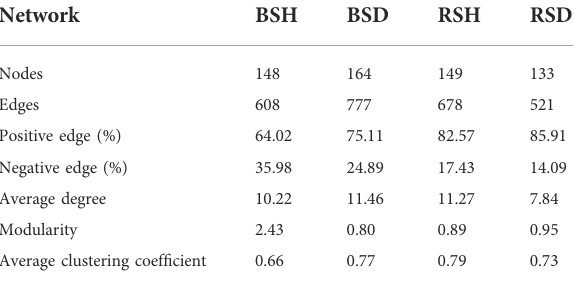
TABLE 2 Microbial co-occurrence network indices. BSD, the bulk soil of the diseased plants. RSH, the rhizosphere soil of healthy plants. RSD, different letters show signi fi cant difference among